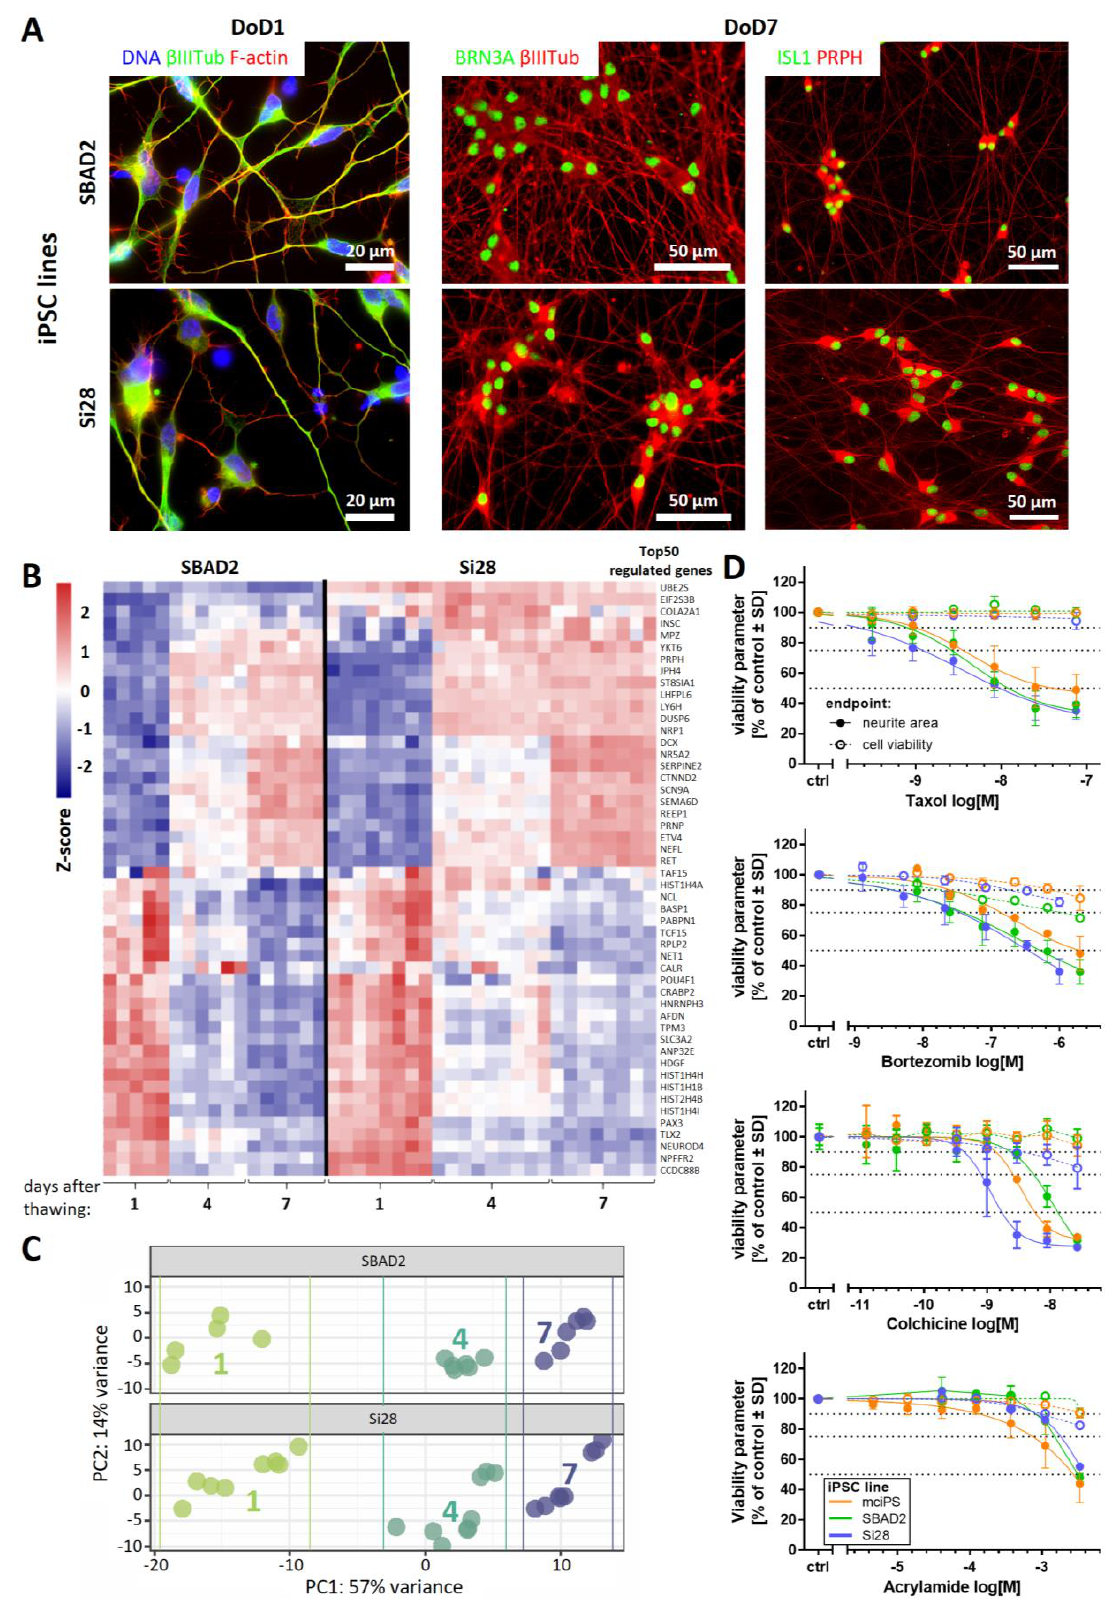
Figure 1. Reproducible generation of peripheral neurons from different iPSC lines and their use in the PeriTox test. ( A ) Peripheral neurons derived from the iPSC lines SBAD2 and Si28 were fixed and stained on DoD1 (left) for the neuronal cytoskeletal marker βIII -tubulin (βIIITub, green) and F-actin